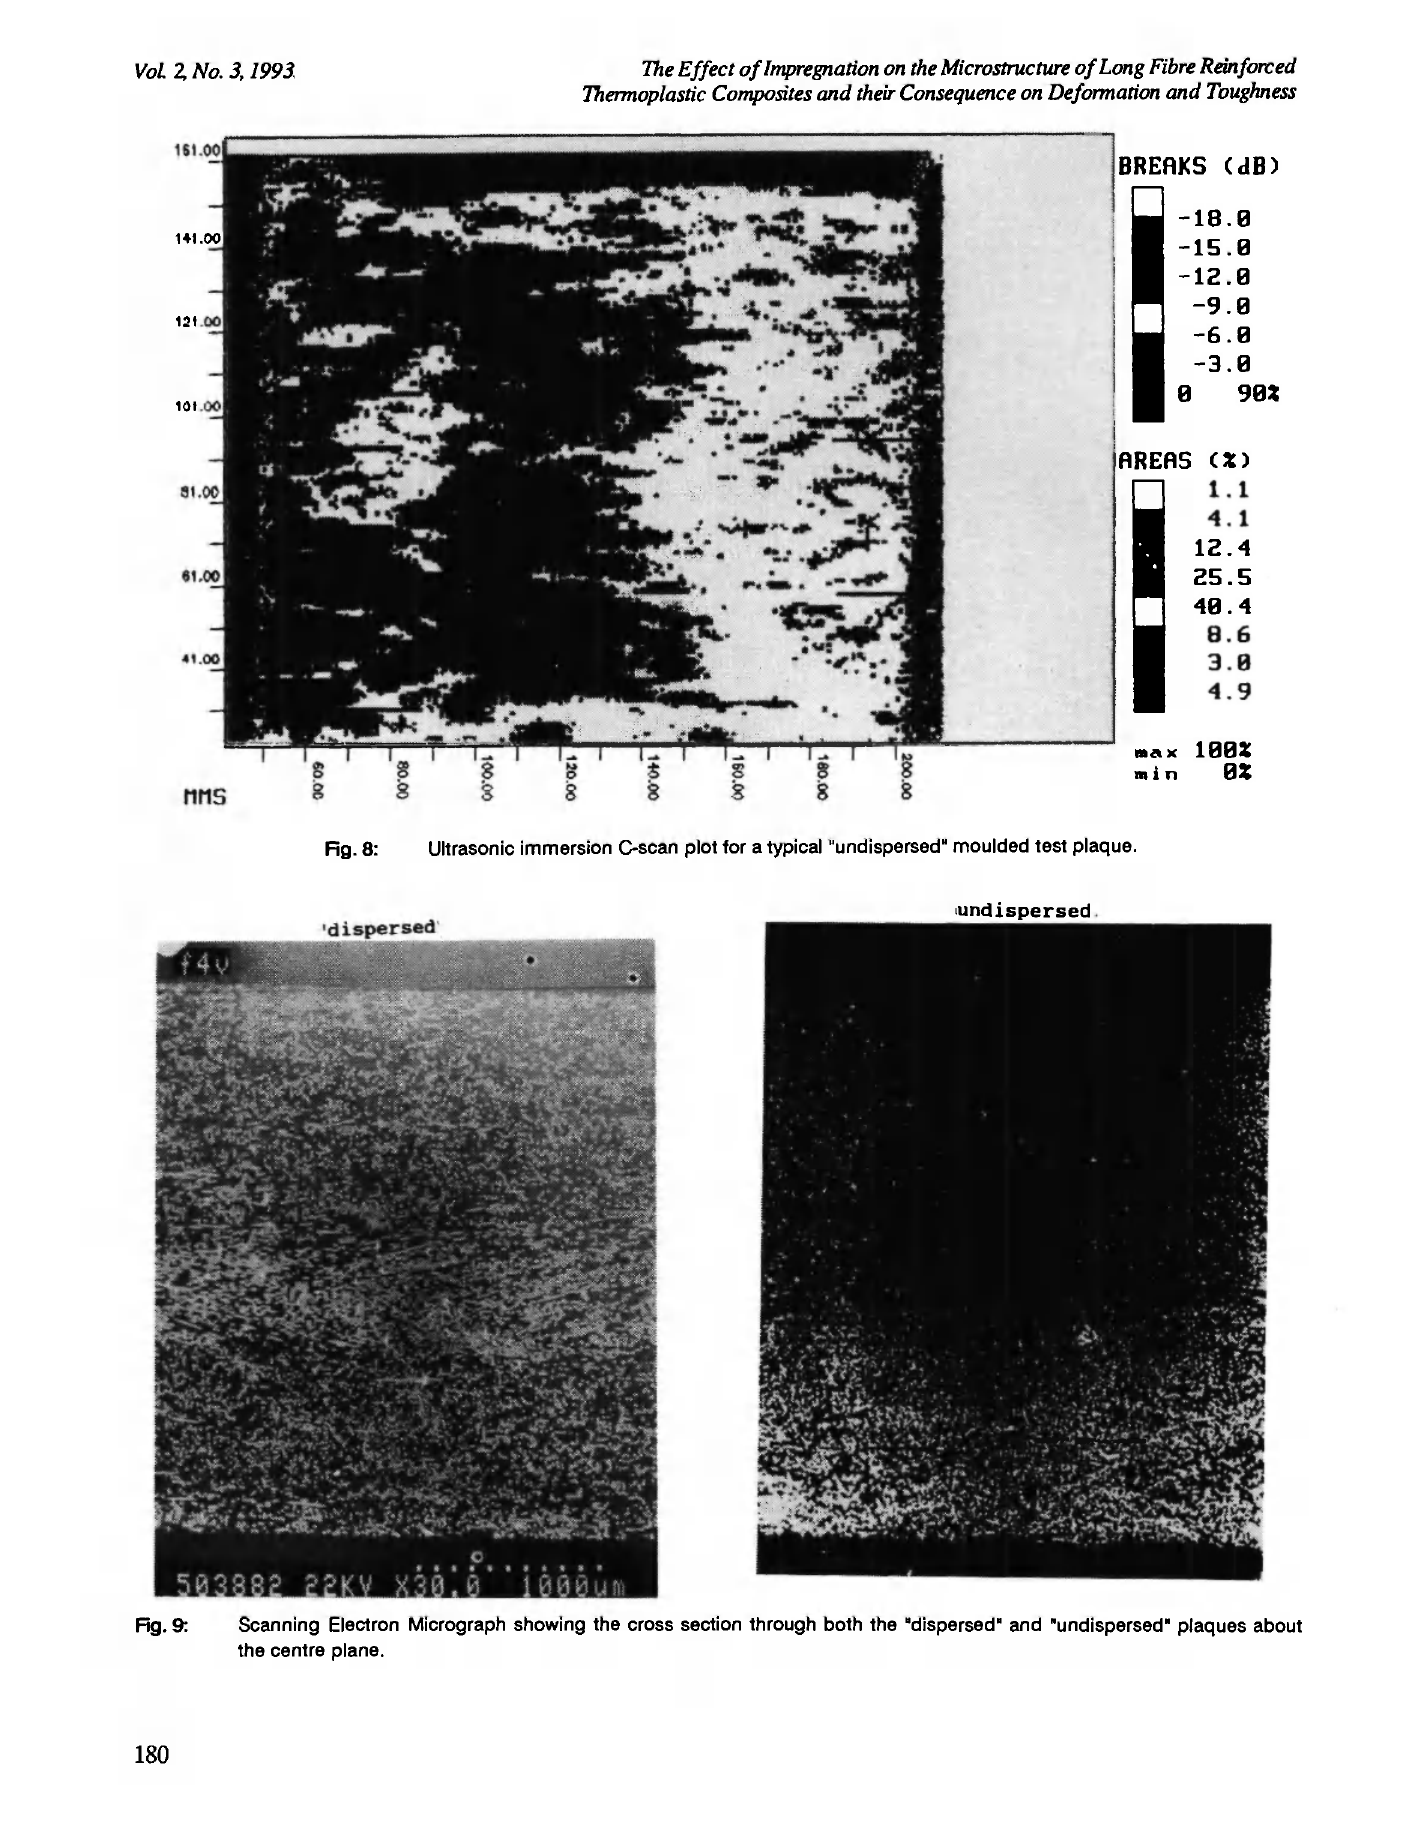
Fig. 9: Scanning Electron Micrograph showing the cross section through both the "dispersed" and "undispersed" plaques about the centre